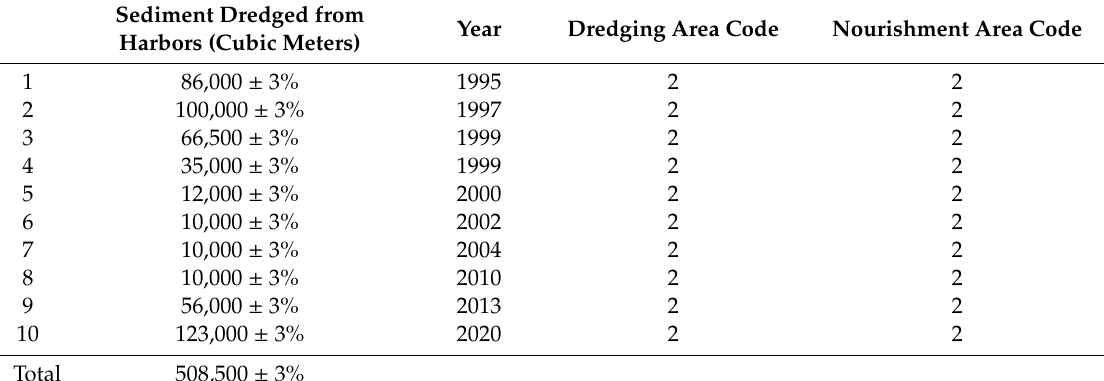
Table 5. Volume of sediments dredged from the harbor at Marina di Carrara and redistributed as sediment transfer in the 1980–2020 timespan along the considered sector of coast, sorted by year of occurrence. Refer to Table S2 for a detailed list of each transfer